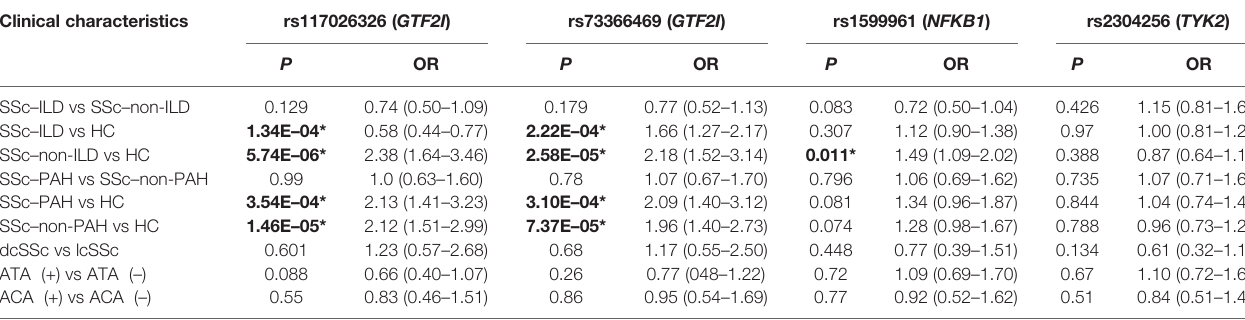
TABLE 5 | Associations between SNPs and patients with SSc with different clinical characteristics. Clinical